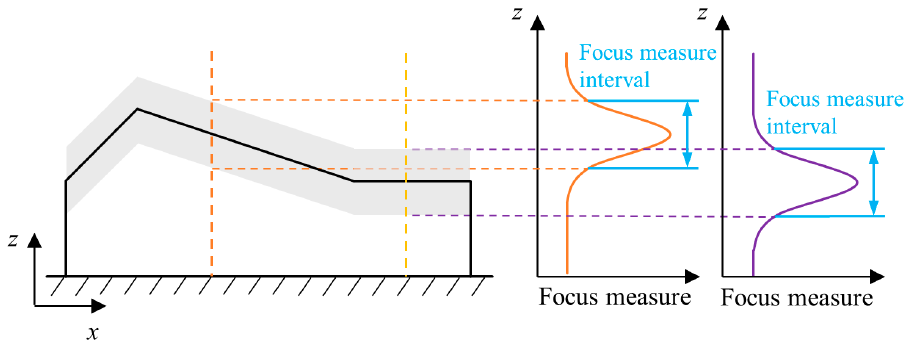
Figure 4. Measured object model and ideal focus measure interval.